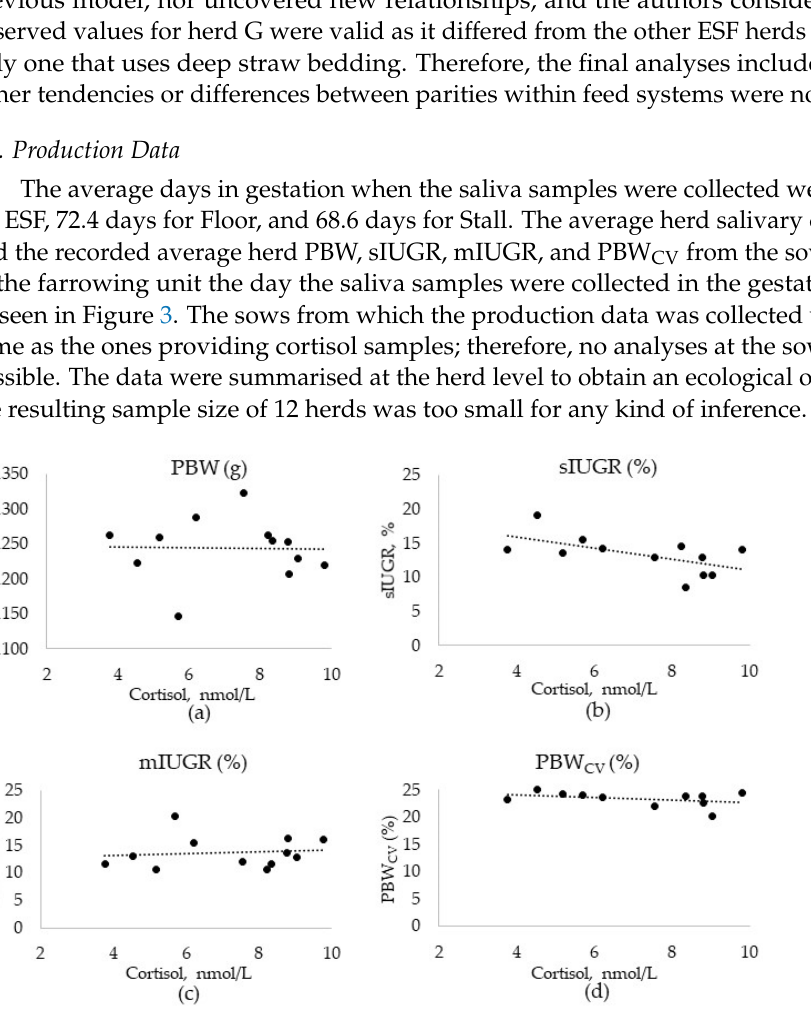
Figure 3. Herd levels of salivary cortisol concentrations (nmol/L) during gestation compared to the herd ( a ) LSmeans of piglet birth weight (PBW), ( b ) percentage of severe IUGR (sIUGR), ( c ) percentage of mild IUGR (mIUGR), and ( d ) within litter variation of PBW (PBW CV ) for herds within feed systems for sows of 2nd to 9th parity on the sample day.